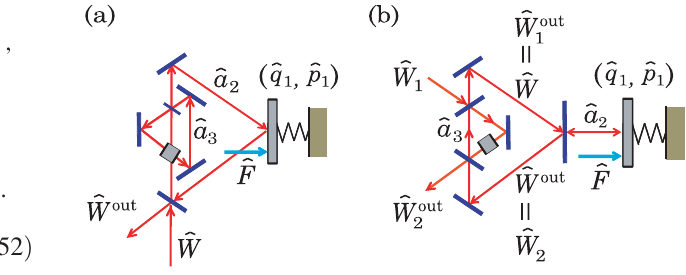
FIG. 8. (a) Direct interaction scheme achieving BAE for the optomechanical oscillator, proposed by Tsang and Caves